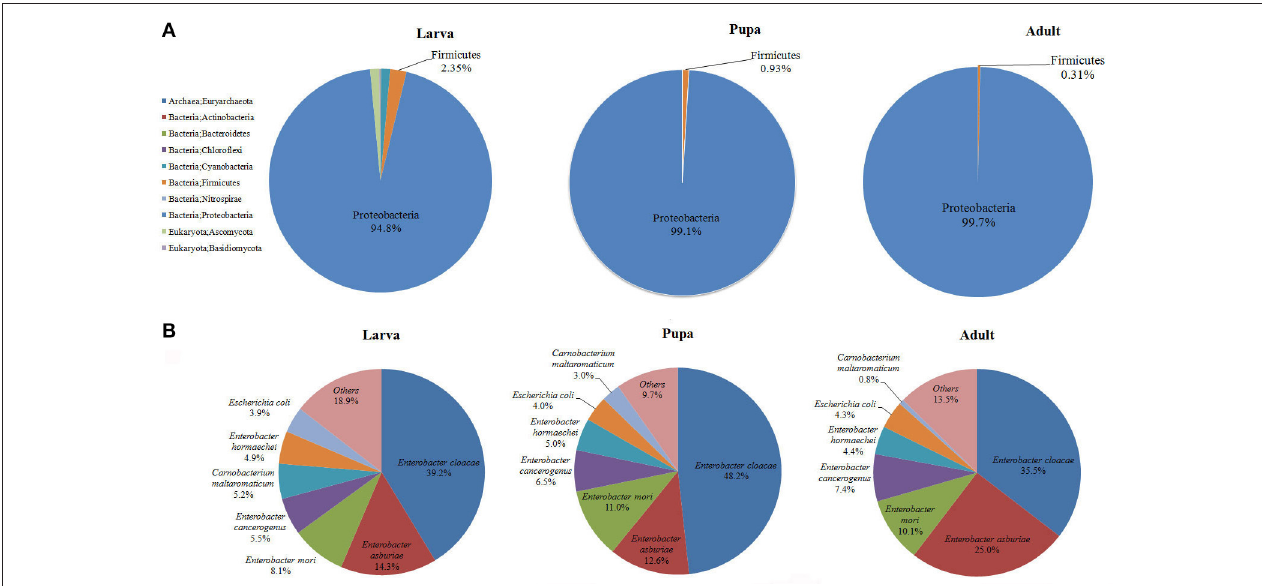
FIGURE 1 | Proportional composition of microbiota in the P. xylostella gut generated from the metagenomics data. Composition at the phylum level (A) , and composition at the species level (B) .